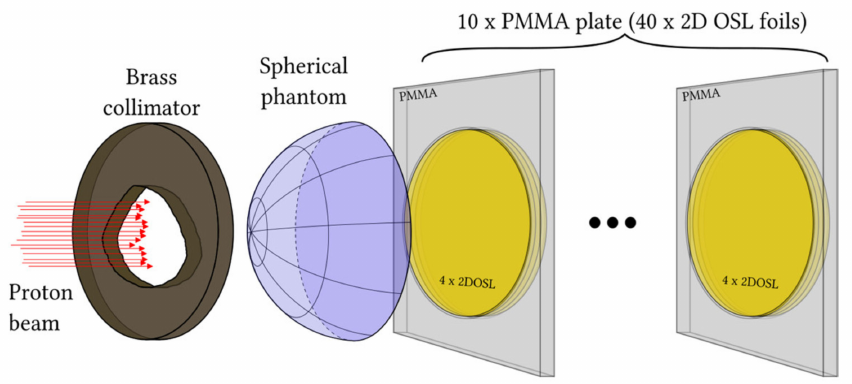
Figure 5. The construction of the eyeball phantom used for proton irradiations. The 40 silicone 2D LMP foils stacked tightly together, inside the hole constructed from the 10 PMMA holders behind a spherical phantom.